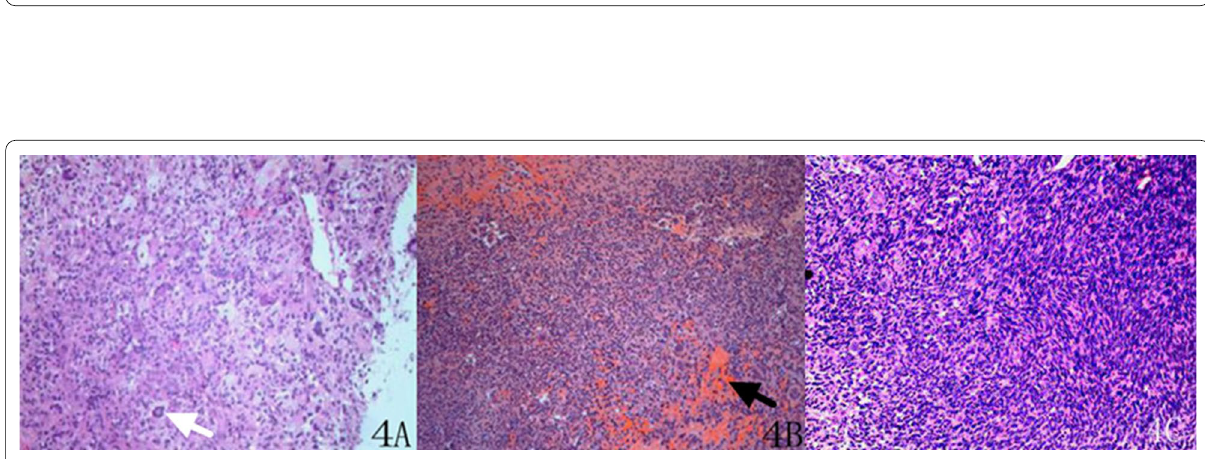
Fig. 4 A Benign GCTTS showed mixed inflammatory cells, foam cells and haemosiderin, accompanied by multinucleated giant cells (white arrow) and fibrosis. The cells had no obvious atypia, HE 10 10. B Malignant GCTTS showed multifocal cystic changes, necrosis and haemorrhage (black × arrow), HE 10 10. C Malignant GCTTS comprised densely arranged splindle mononuclear cells, showing enlarged nuclei and an increased mitotic × count. Multinucleated giant cells could be identified among the mononuclear components, HE 10 ×